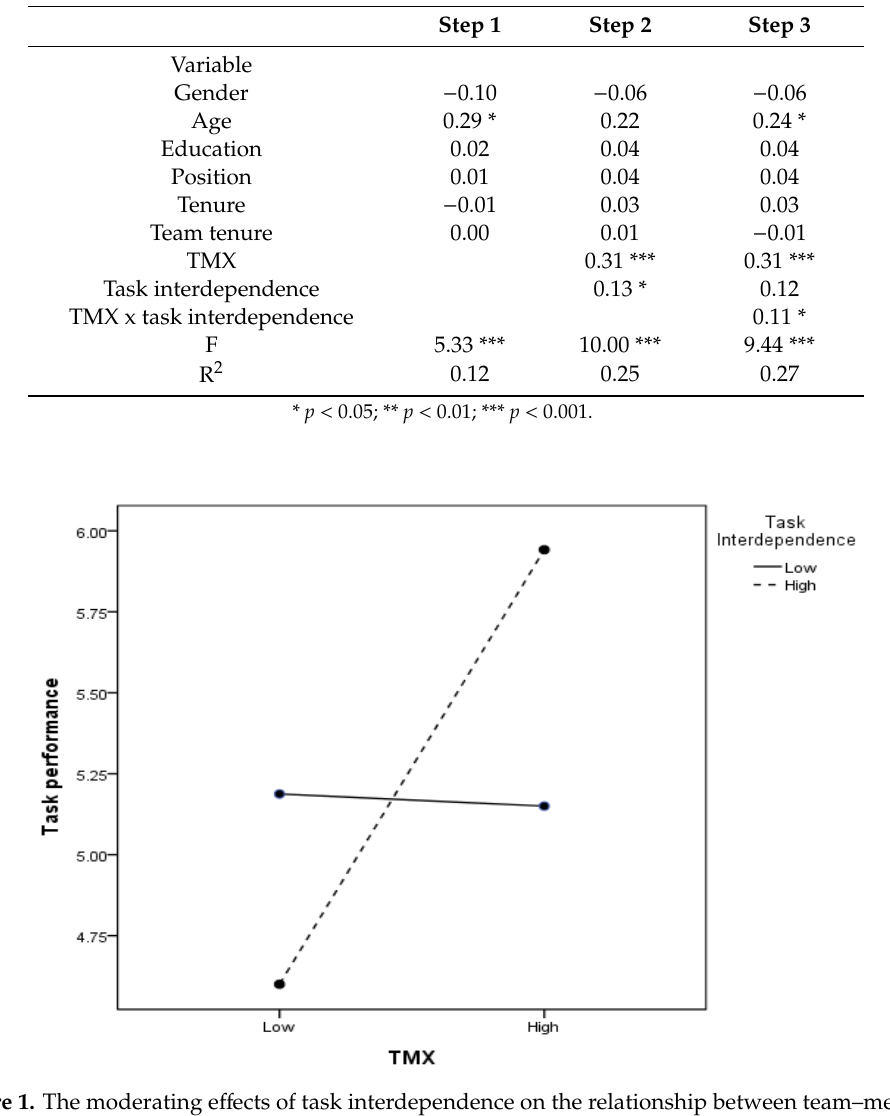
Figure 1. The moderating e ff ects of task interdependence on the relationship between team–member exchange (TMX) and task performance.